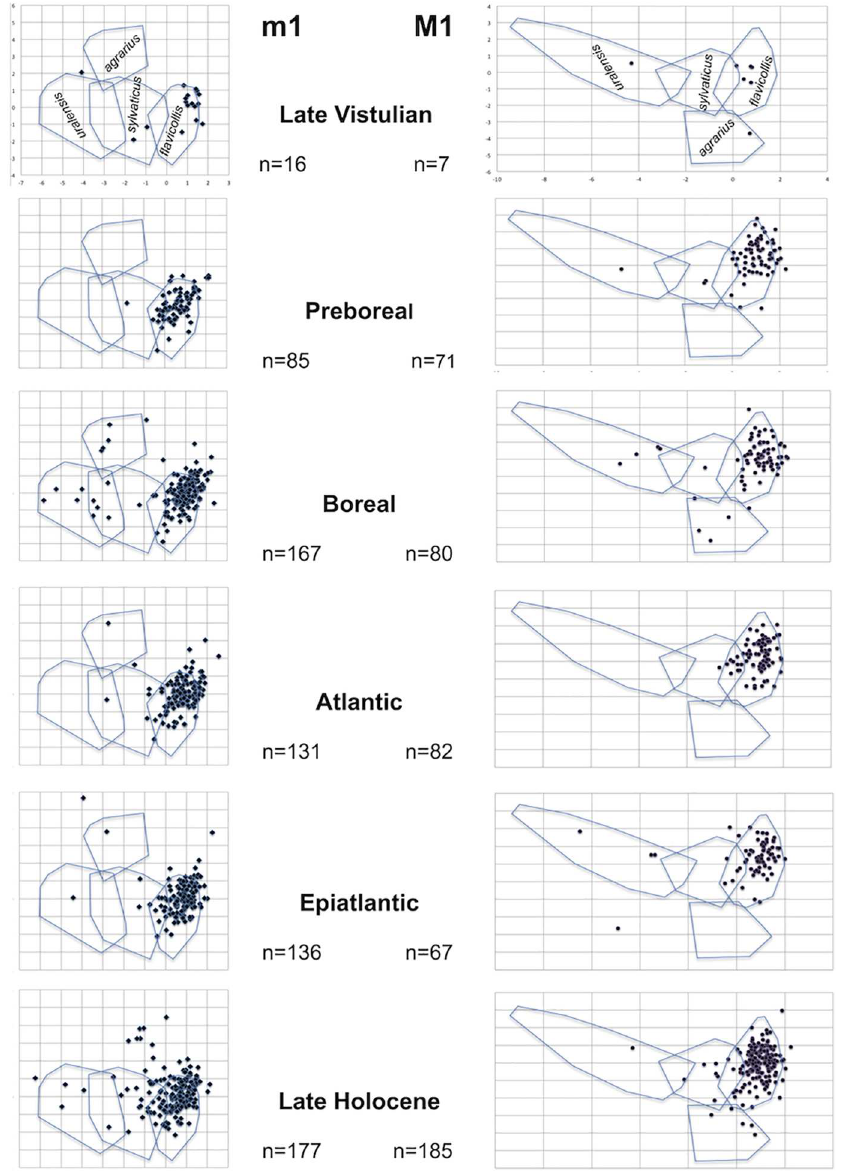
Fig 7. Plot of discriminant scores(R1/R2) of individual M1 (right) and m1 (left) teeth of Apodemus spp. from particular stagesof Late Pleistocene / Holocene stratigraphy superimposed onto a plot of variation rangesin the respective variablesfor the Recent Apodemus sample (basedon the discrimination analysisof metricvariablesof M1 and both metricand non-metric variableof m1). Note the extensive predominance of A . flavicollis